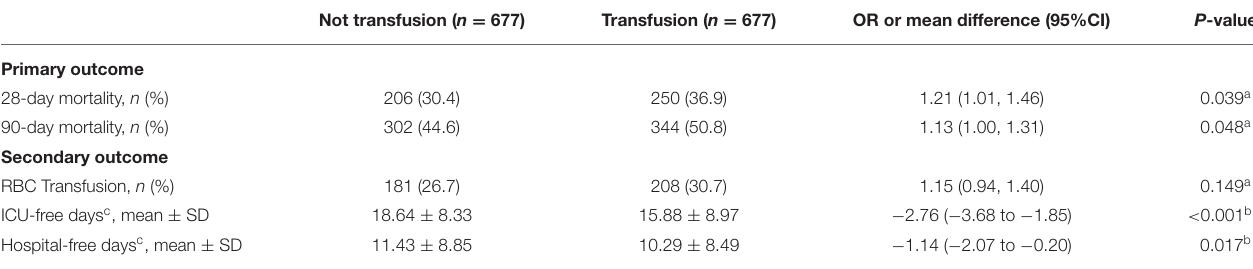
TABLE 2 | Primary and secondary outcomes in the propensity score matched